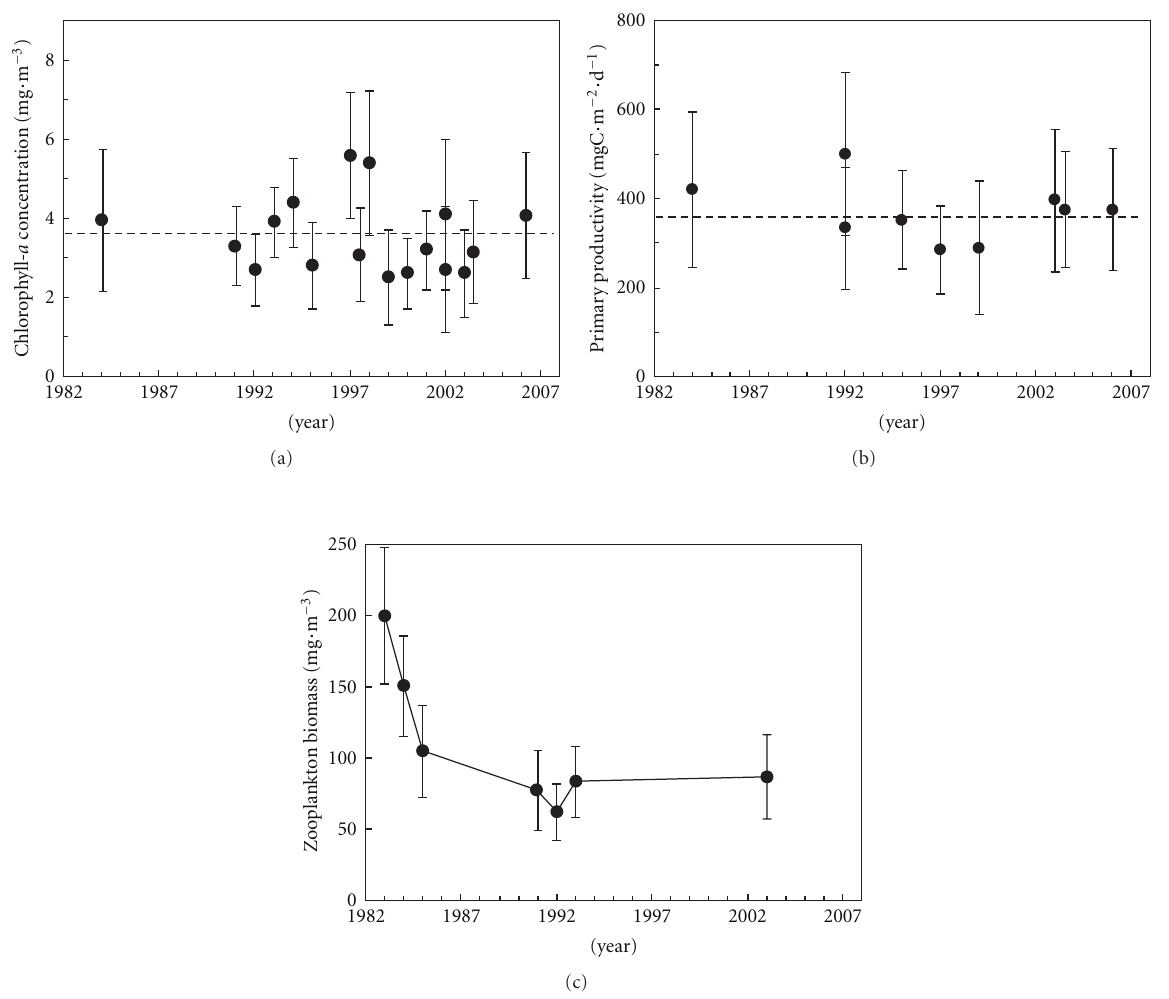
Figure 3: Long-term variations in chlorophyll a concentration (mgm − 3 ), primary productivity (mg · C m − 2 · d − 1 ), and zooplankton biomass (mgm − 3 ) in Jiaozhou Bay (the dashed lines indicate average